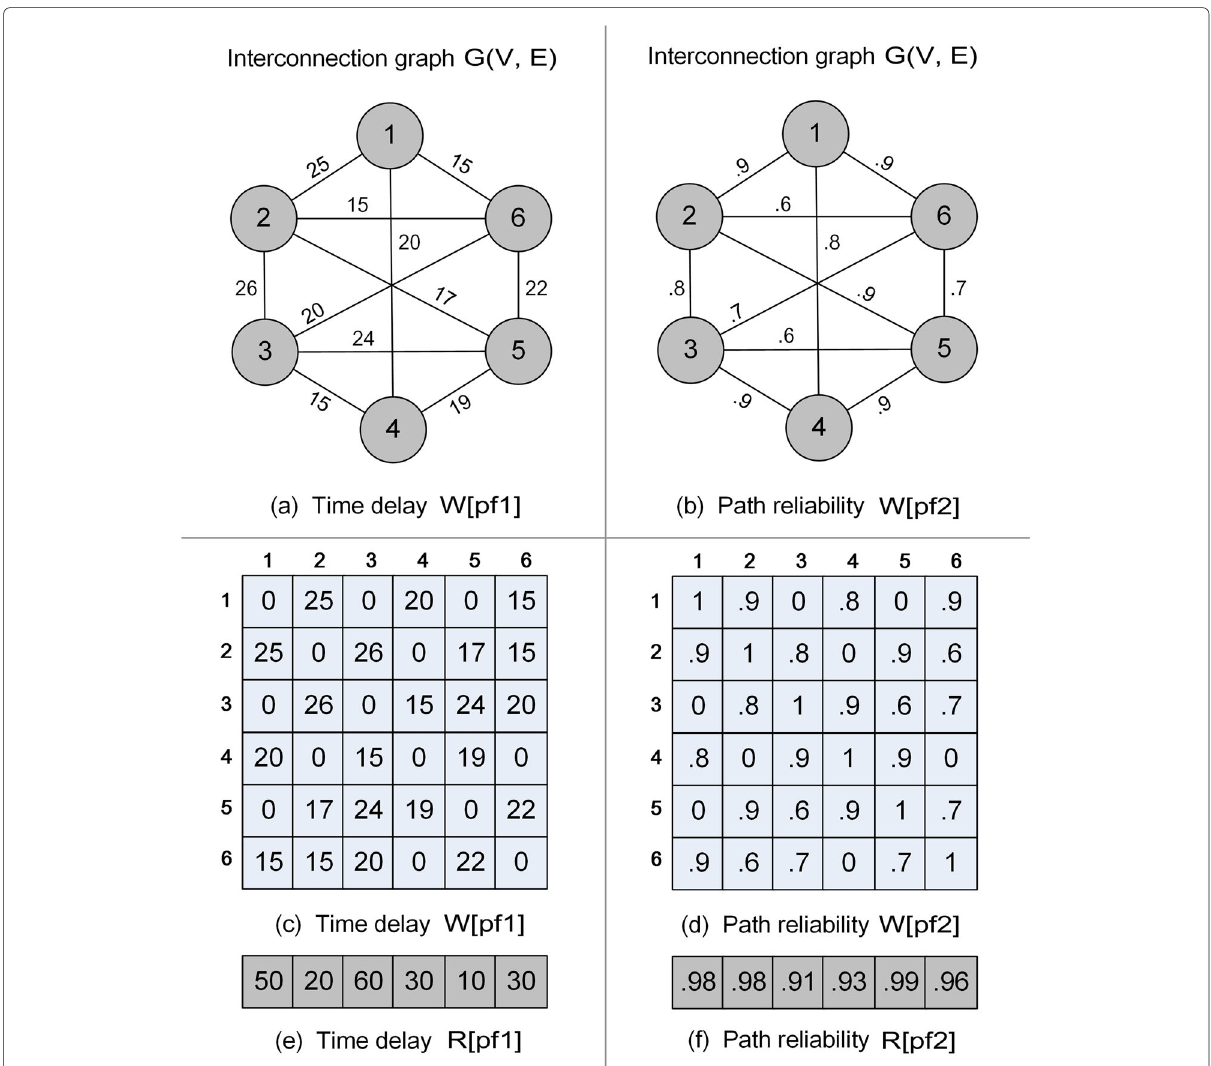
Fig. 11 PEM metrics calculation in a process of construction the R-TBC tree of consistency with replica servers of heterogeneous cloud environment